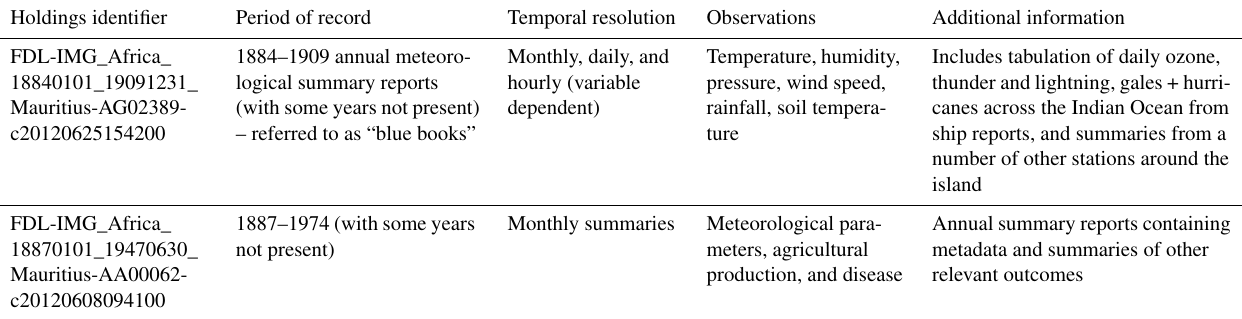
Table 1. Brief summary of the two sets of image holdings archived by NOAA NCEI that pertain to the Royal Alfred Observatory. The first collection is of blue books, two of which were missing in the NOAA NCEI collection and were sourced from the NOAA Foreign Data Library. The second is the annual report series. Neither is continuous in the NCEI holdings. See Fig. 10 for indications as to availability of individual logbooks across the period of the present